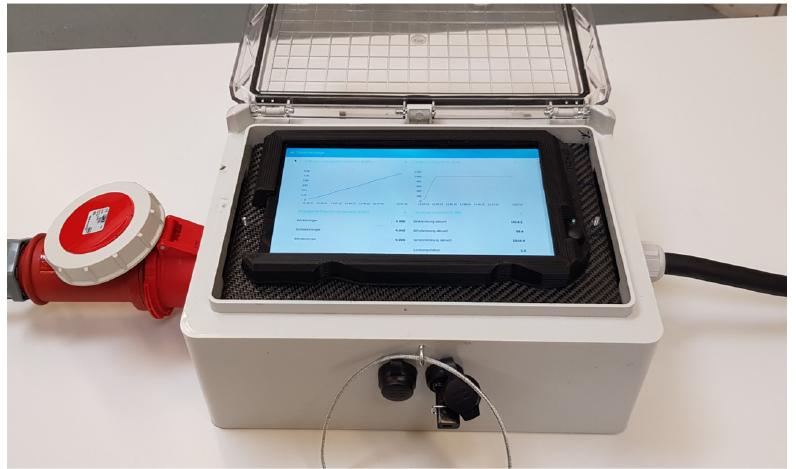
Figure 3. Developed measuring box